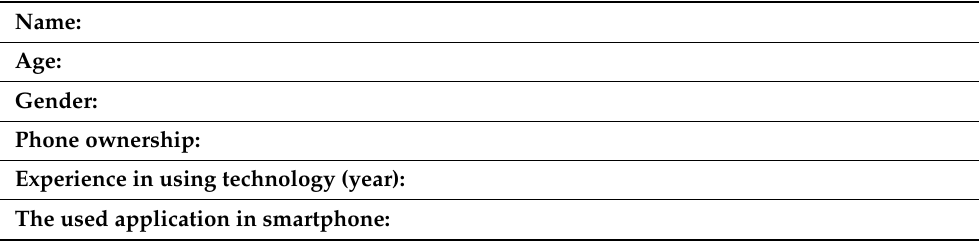
Table A1. User’s demographic questionnaire of survey.